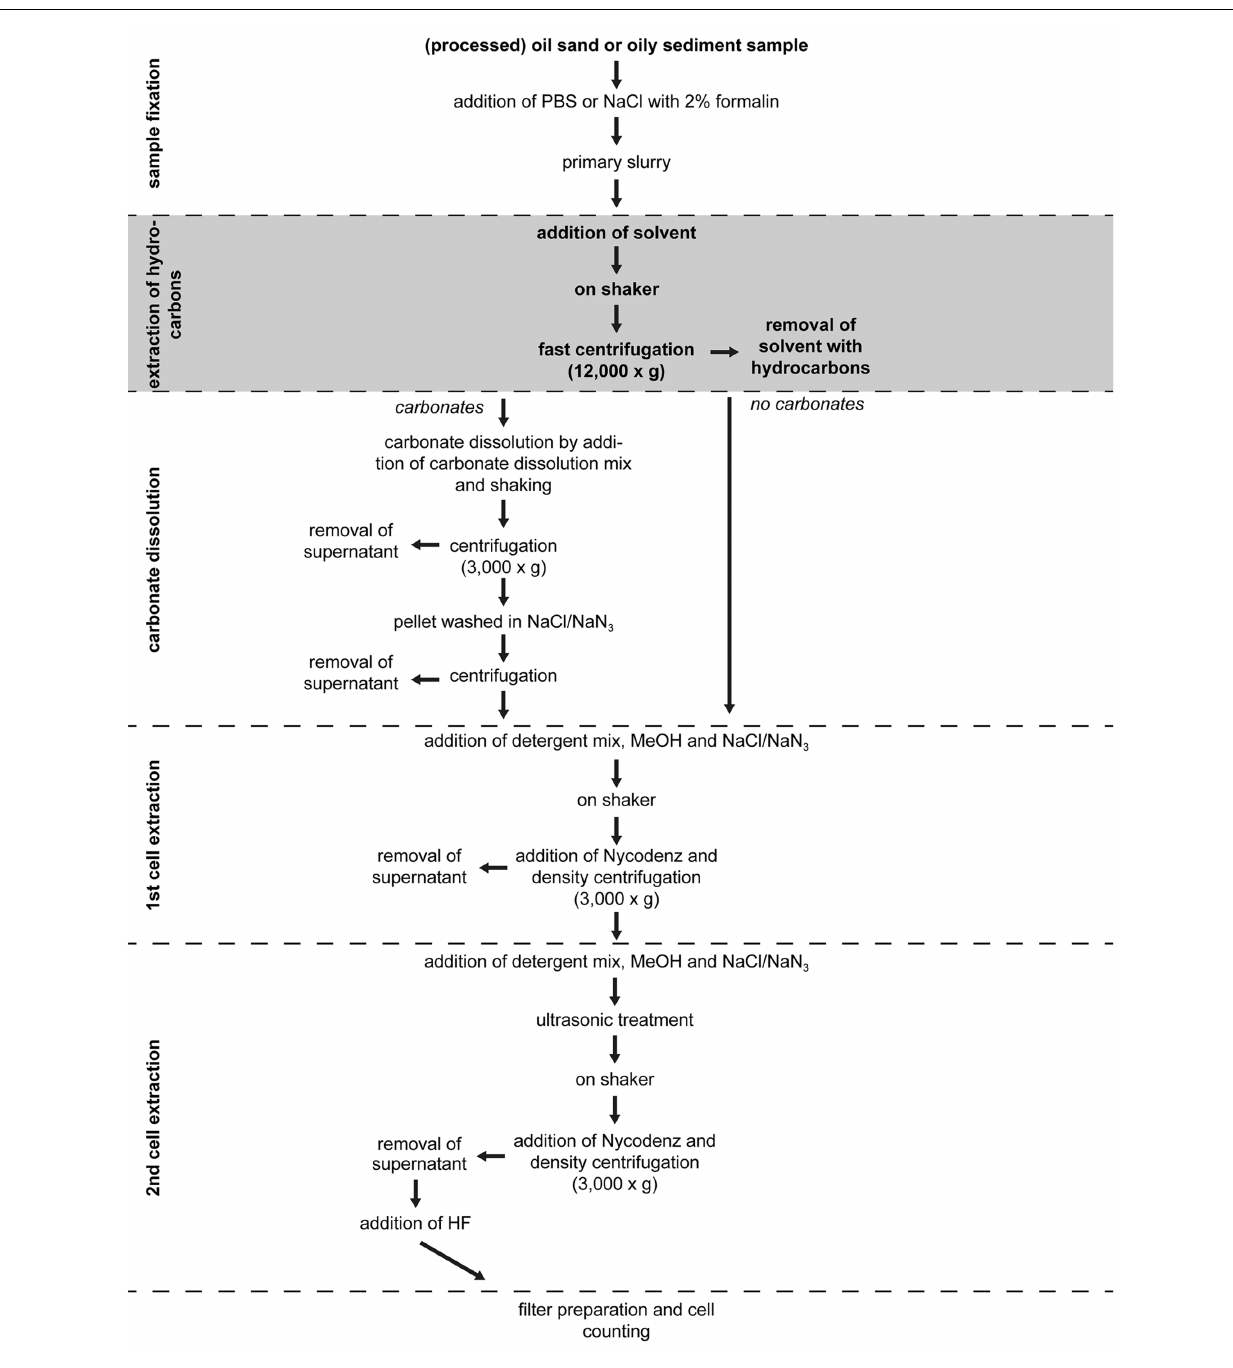
FIGURE 1 |The flow chart shows the complete hydrocarbon and cell extraction procedure for oily sediments. The method is based on the cell extraction procedure of Kallmeyer et al. (2008).The hydrocarbon extraction step is shaded. Details about incubation times and amounts of reagents are provided in the